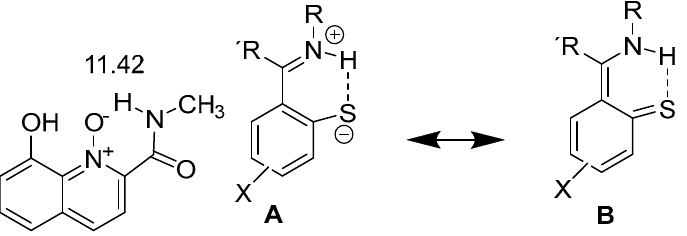
or 17.33 ppm for CH 3 =PhCH 3 , R (cid:48) =CH 3 or 18.2 ppm for R=PhOCH 3 and R (cid:48) =CH 3 [44]. Similar values were also obtained for derivatives in which R (cid:48) is H [45].